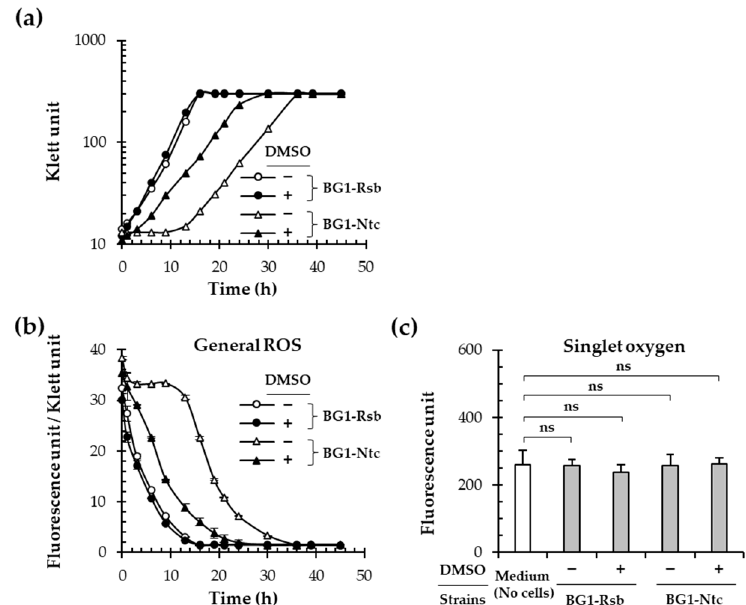
Figure 6. The photoheterotrophic growth of BG1-Ntc ( a ) was examined in the presence (closed symbol, +) or absence (open symbol, − ) of 2 mM DMSO. BG1-Rsb was used as the control. General ROS levels were determined during the growth period using H 2 DCFDA ( b ). Singlet oxygen levels were determined using SOSG 1 h after the onset of photoheterotrophic growth ( c ). Significances were assessed using the Student’s t -test: ns, p > 0.05.